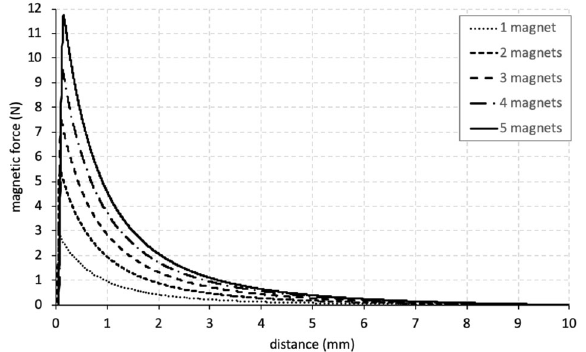
Fig. 3 The magnetic attraction forces as a function for the distance between the magnets for one until fi ve